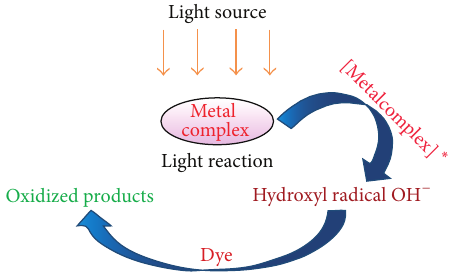
Figure 5: Photodegradation mechanism of metal